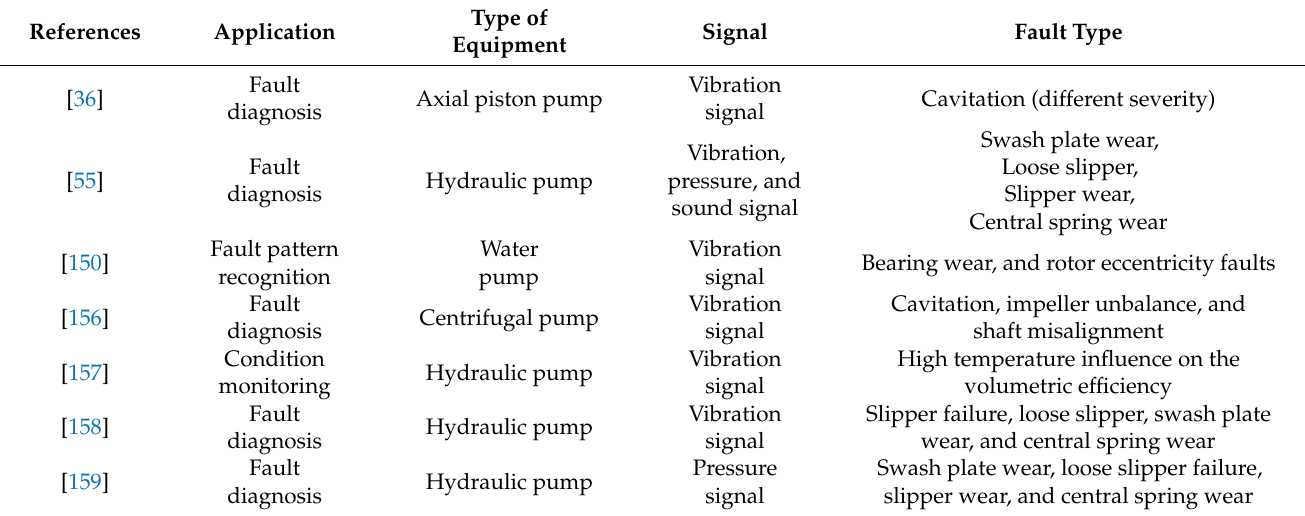
Table 19. Pump condition monitoring using convolutional neural